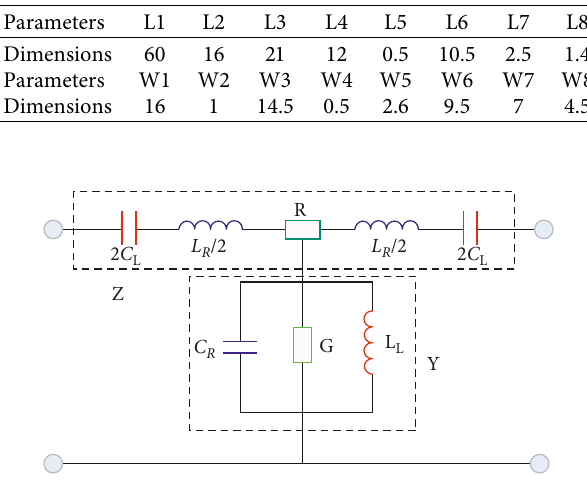
Figure 2: Equivalent circuit diagram of the CRLH TLs.